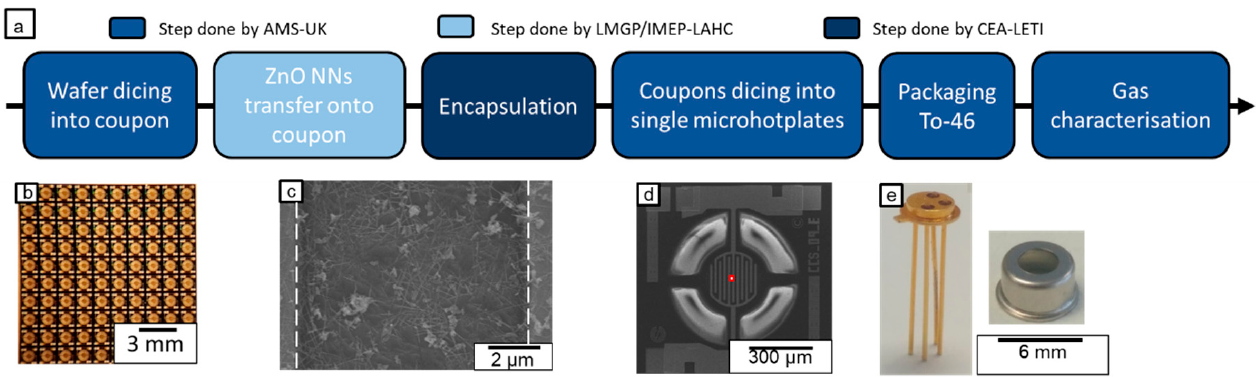
Figure 1. ( a ) Scheme presenting the main steps of device fabrication and packaging as done by each partner, ( b ) Optical image of a coupon, ( c ) SEM image of an encapsulated NN, ( d ) SEM image of a microhotplate and ( e ) Optical image of To-46 packaging. Table 3. Summary of all the different type of devices based on ZnO NN investigated in this work.